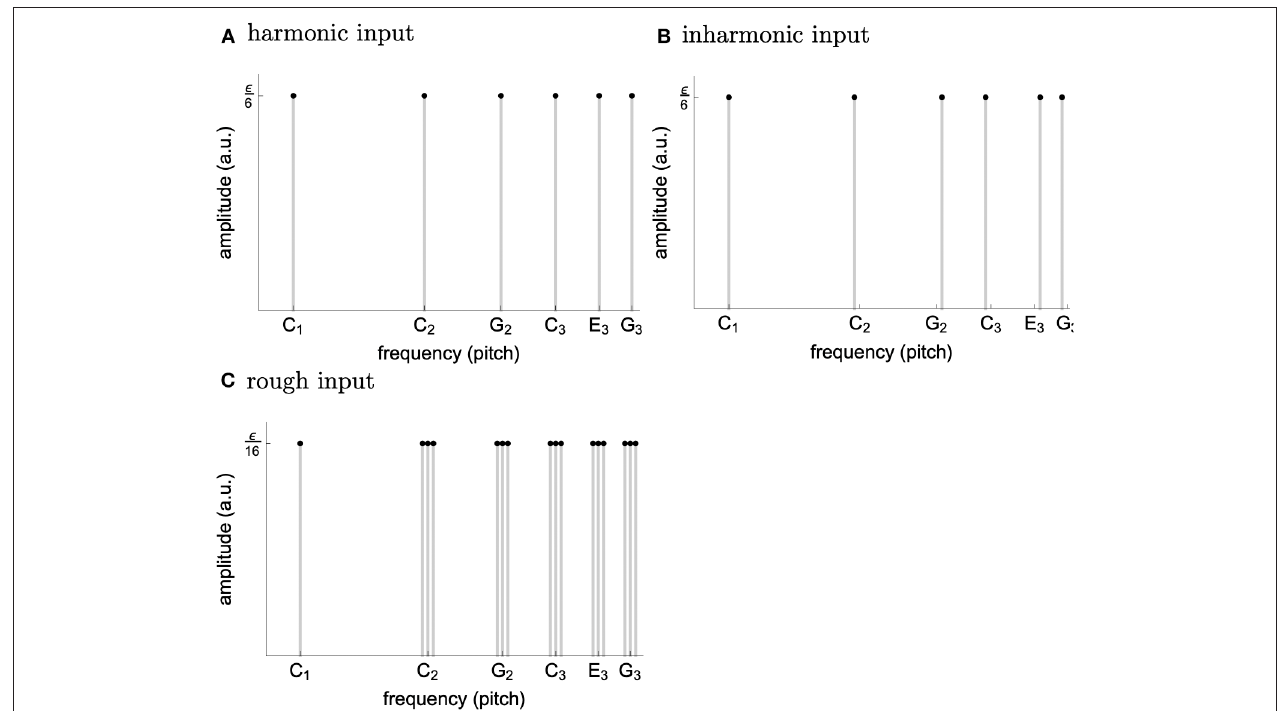
FIGURE 4 | Spectrum of the harmonic (A) , inharmonic (B) , and rough (C) input used in the simulations. The construction loosely follows the procedure from [11]. We chose ǫ 3 for the soft and ǫ 5.4 for the loud inputs. = =